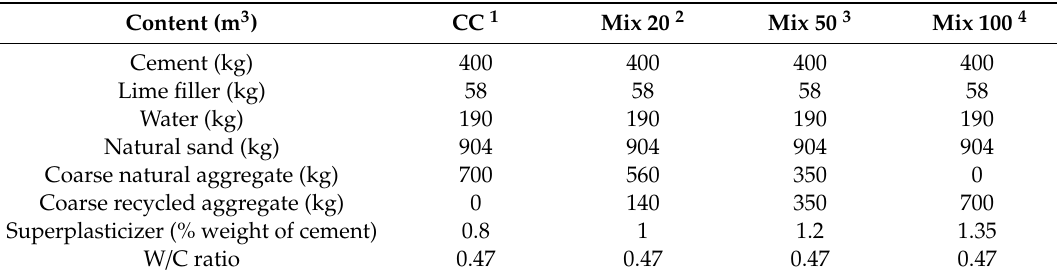
Table 6. Mix proportion (kg / m 3